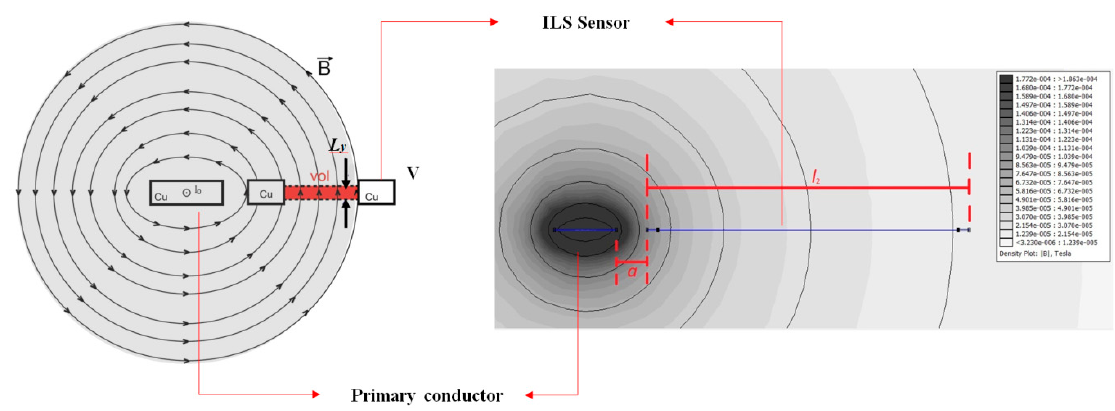
Figure 5. Representation of the distribution of B in FEMM.